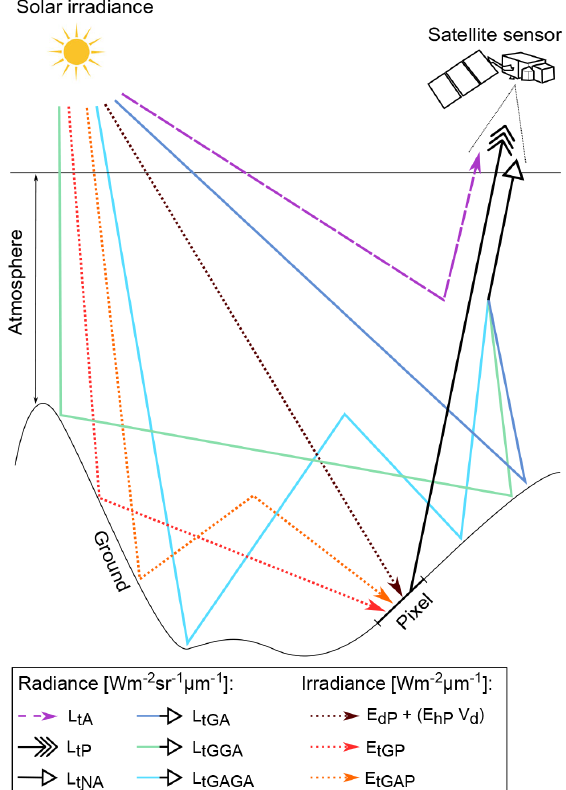
Figure 1. Illustration of the contributing fluxes to the TOA radiance measured by a space-borne sensor. The dotted lines correspond to solar irradiance received by the pixel P which are then reflected to- wards L tP , the sensor’s instantaneous field of view (IFOV); the solid coloured lines represent the contribution of neighbouring slopes to the measured signal ( L t N A ), and the dashed line is the atmospheric path radiance ( L tA ). For sake of clarity, the direct and diffuse com- ponents of the downwelling fluxes are merged in this